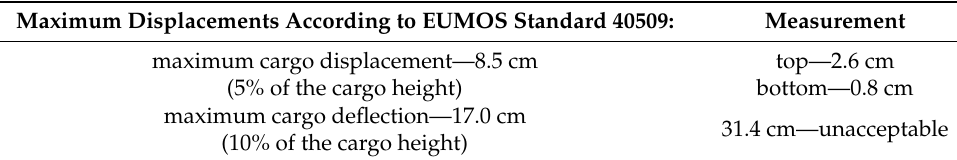
Table 5. Cargo displacement parameters during the 0.5 g acceleration test for standard foil.